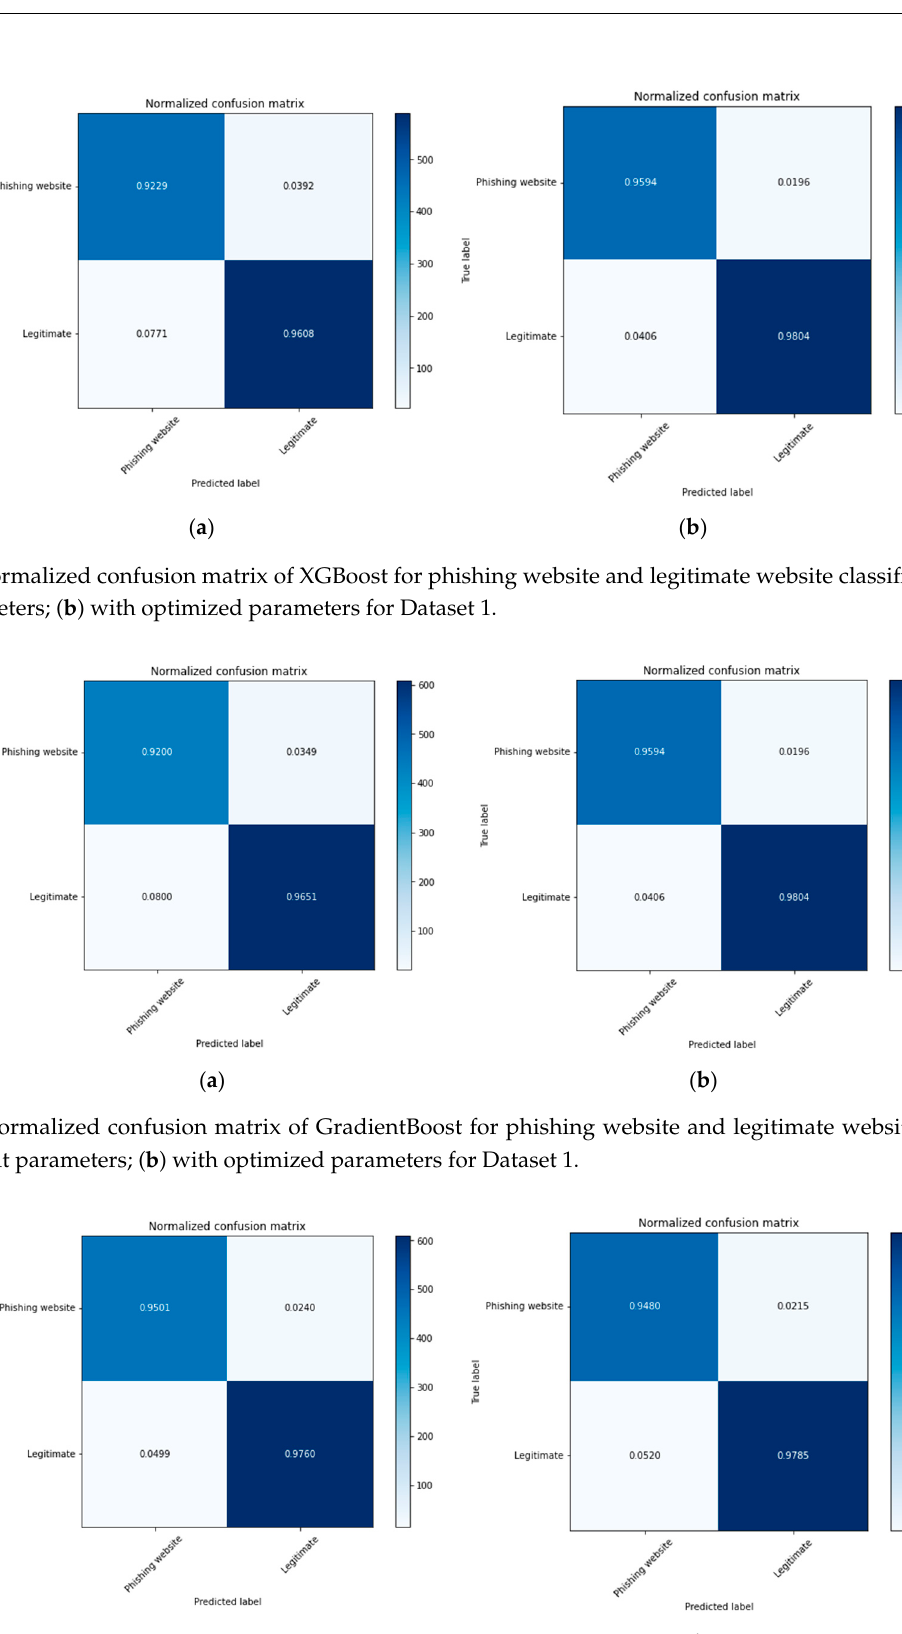
Figure 5. A normalized confusion matrix of Random Forests for phishing website and legitimate website classification: ( a ) with default parameters; ( b ) with optimized parameters for Dataset 1.